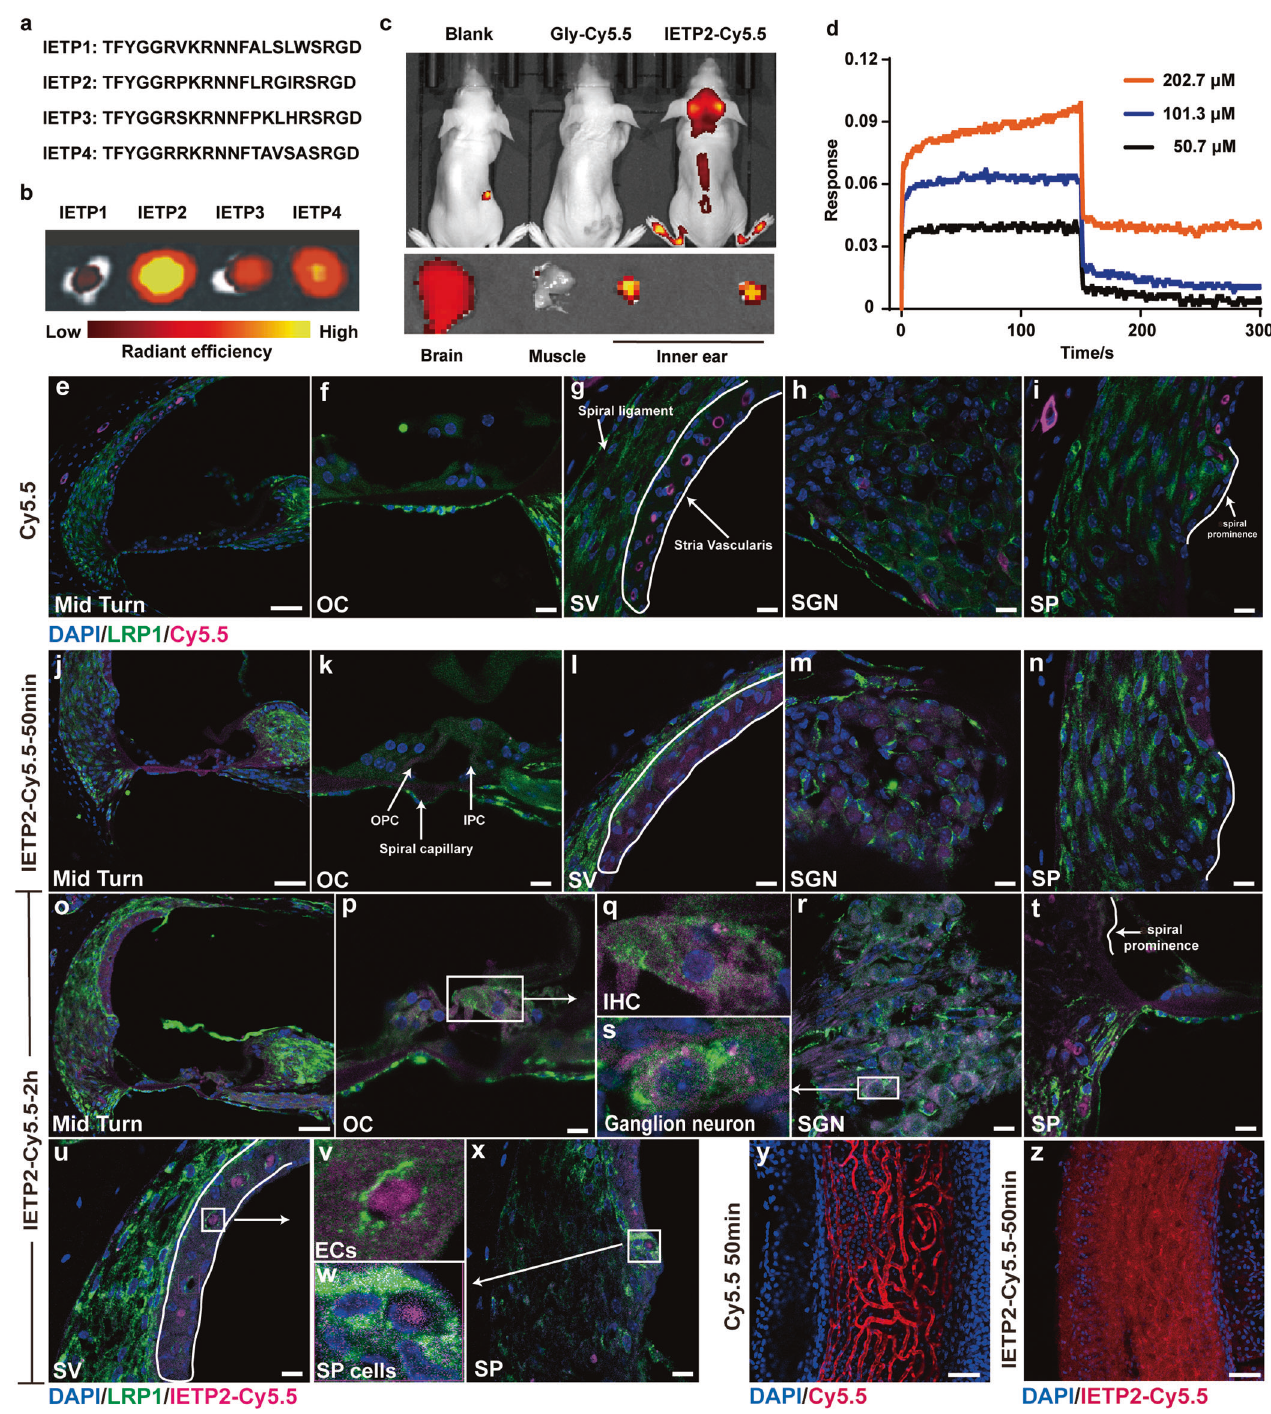
Fig. 2 Identi fi cation of inner ear-targeting peptides and validation of the ability to cross the BLB in vivo. a Amino acid sequences of the four candidate IETP peptides. b Ex vivo fl uorescence imaging showing the uptake of the four IETP peptides in mouse cochleae. c In vivo imaging showing the accumulation of IETP2-Cy5.5 in mouse cochleae. Gly-Cy5.5 served as a negative control. d Kinetic analysis of IETP2 binding to LRP1. A dissociation constant (K D ) of 738 nM was obtained. e – i Immuno fl uorescence imaging of the mouse cochleae injected with Cy5.5. j – n Immuno fl uorescence imaging of mouse cochleae 50 min after the injection of IETP2-Cy5.5. Different regions (midturn, OC, SV, SGN and SP) were displayed, and immunostaining with anti-LRP1 antibody was performed. White arrows indicate regions of interest. o – x Immuno fl uorescence imaging of mouse cochleae 2 h after injection of IETP2-Cy5.5. q , s , v , w Zoomed-in immuno fl uorescence images of OC, SGN, SV, and SP (white rectangular area) in the mouse inner ear showing the colocalization of the receptor LRP1 and IETP2-Cy5.5 in IHCs, neurons, ECs and SP regions. y – z Microscopy images of the mouse cochleae SV injected with Cy5.5 or IETP2-Cy5.5 from a different perspective. Diffuse of IETP2-Cy5.5 into the intrastrial space was observed. DAPI: blue; LRP1: green; Cy5.5 and IETP2-Cy5.5: magenta or red. Scale bars: e , j , o 100 µm, y , z 50 µm, others 10 µm.)